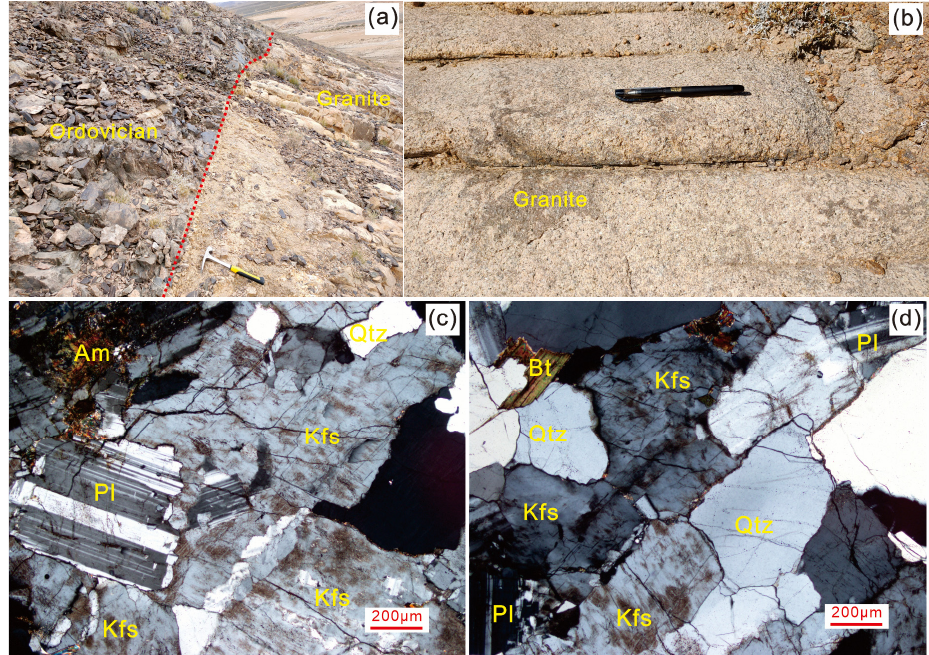
Figure 3. Representative field photographs ( a , b ) and photomicrographs ( c , d ) of the Late Devonian Duhongshan granites. The granite intrudes into the Ordovician silica rock in the Figure 3a. Mineral abbreviations: Q tz = quar tz ; Kfs = K-feldspar; Pl = plagioclase; Bt = biotite; Am = amphibole.